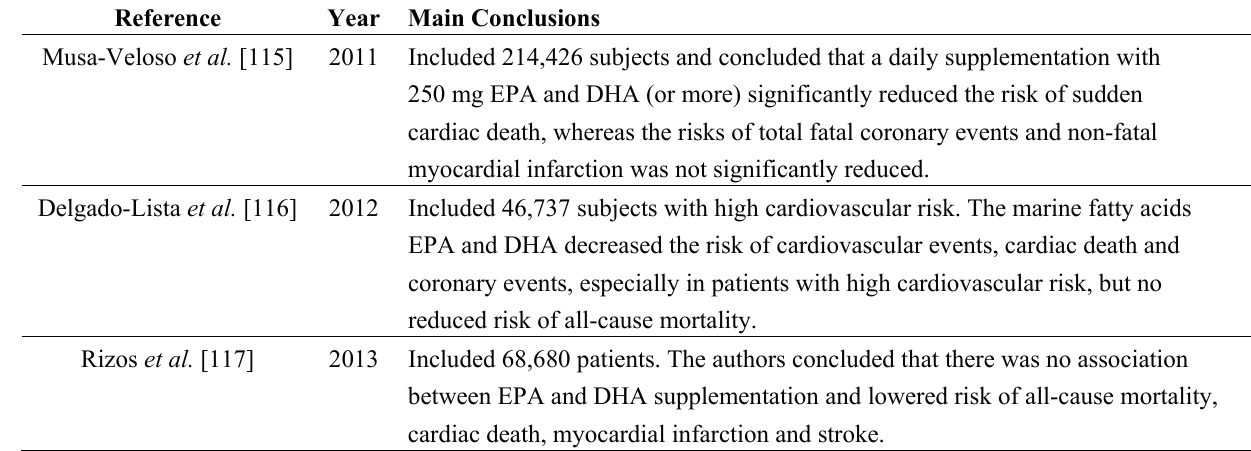
Table 2. Recent systematic reviews and meta-analyses evaluating the association between intake of marine n -3 supplements and risk of cardiovascular